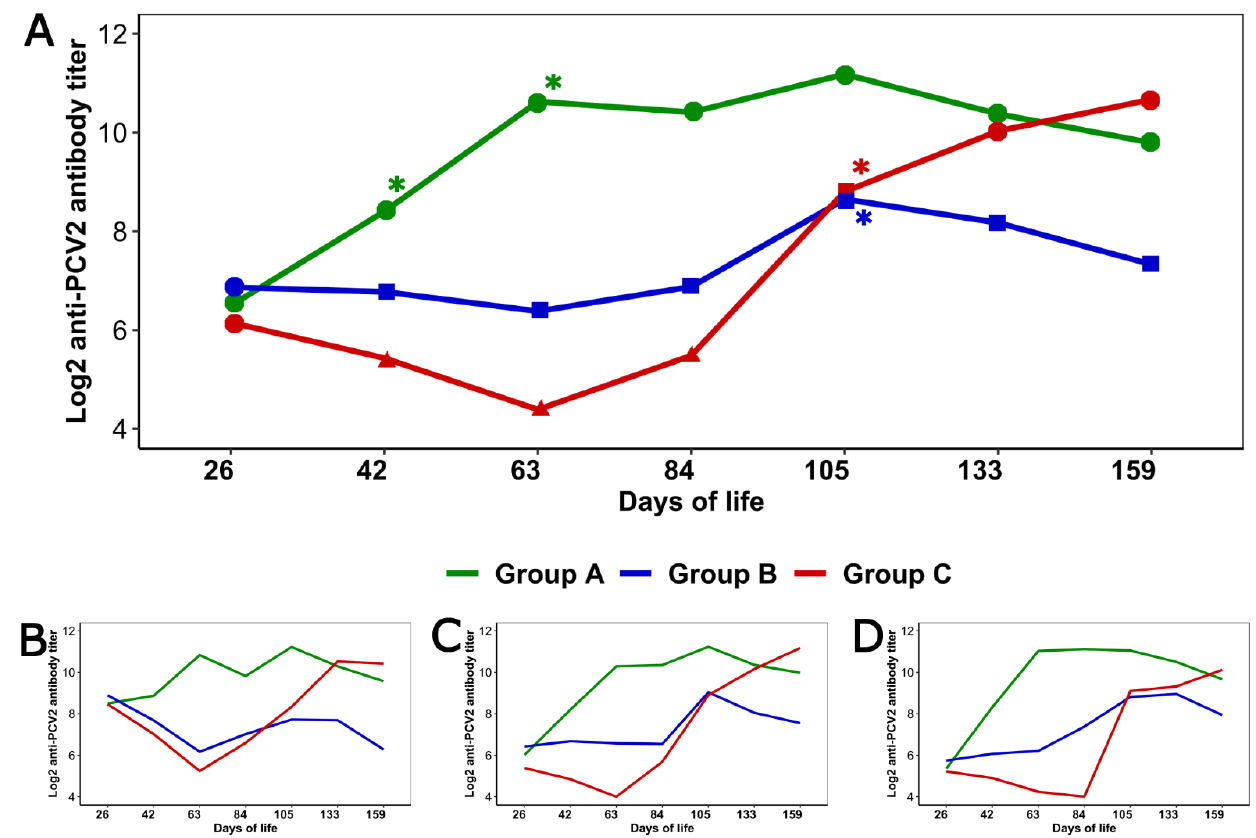
Figure 2. Dynamics of PCV2 serology. ( A ) shows the evolution of PCV2 serology in each group. Different shapes indicate significant differences in the anti-PCV2 antibody levels between the three groups at each sampling. The asterisk (*) indicates the age at which seroconversion was detected in each group. ( B – D ) represent the dynamics of PCV2 serology in each group for pigs from 1st parity sows ( B ), 2nd to 4th parity sows ( C ) and ≥ 5 th parity sows ( D ).